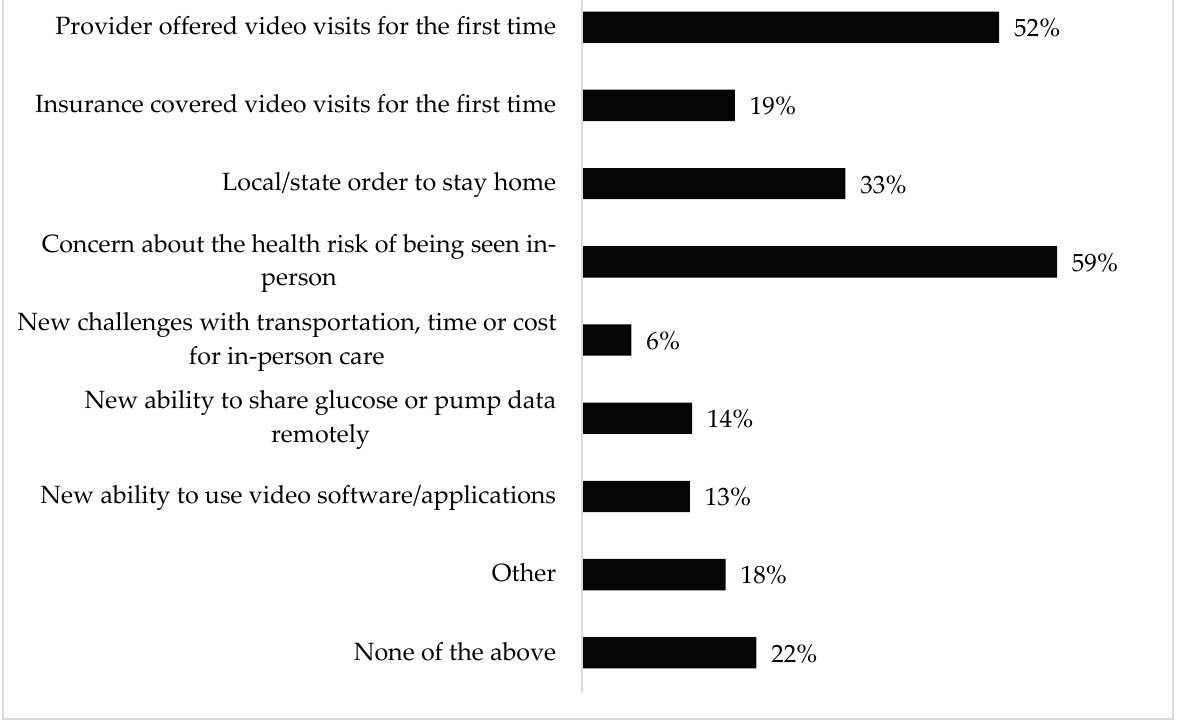
Figure 1. Factors Influencing Survey Respondents’ ( n = 1393) Adoption of Video Care During COVID-19.